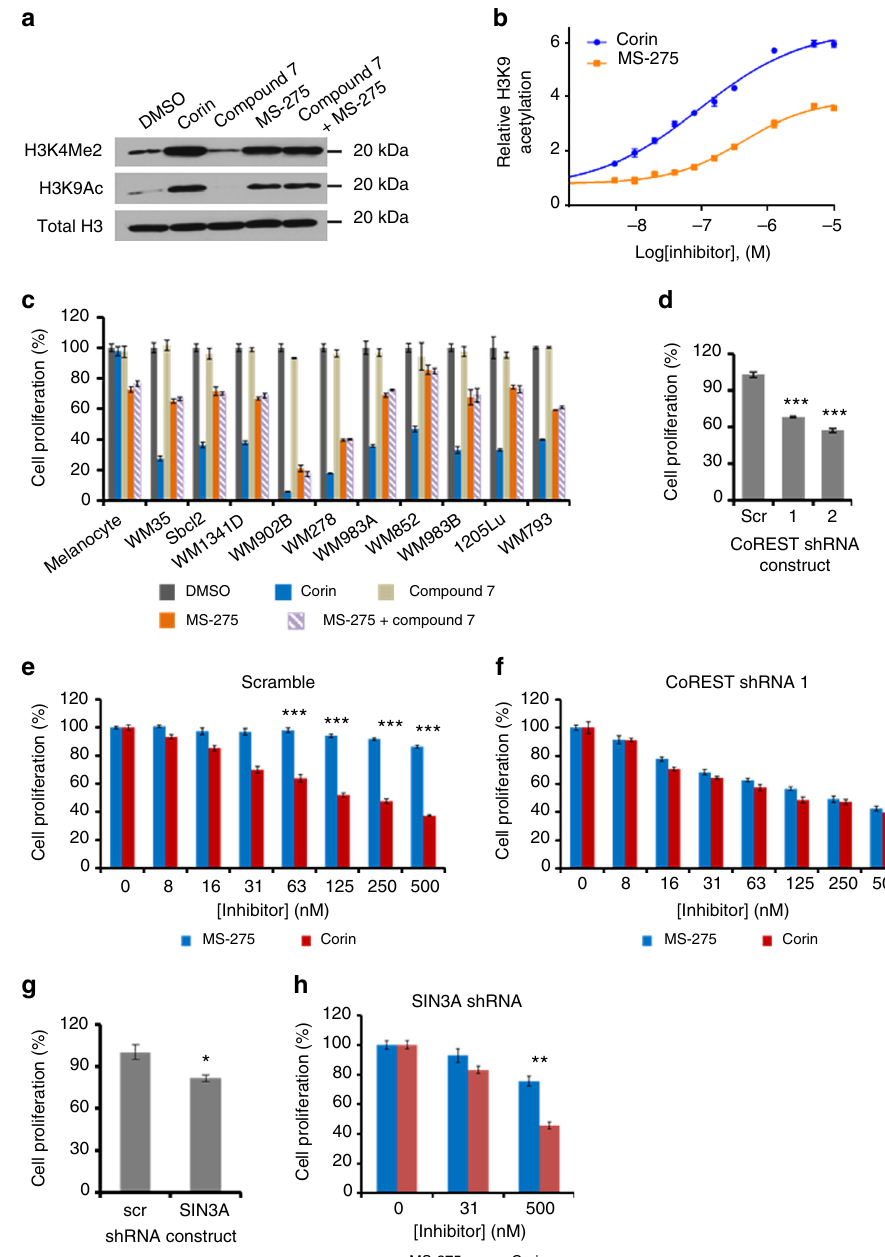
Fig. 4 Pharmacologic effects of corin and related compounds on melanoma cells and the role of CoREST. a Western blot depicting increases in histone H3K4 methylation and H3K9 acetylation in WM983B melanoma cells induced by 10 µ M inhibitor treatment. b Corin (EC 50 = 0.095 ± 0.017 µ M) was more potent than MS-275 (EC 50 = 0.42 ± 0.07 µ M) and more ef fi cacious at inducing histone H3K9 acetylation in WM983B melanoma cells as determined